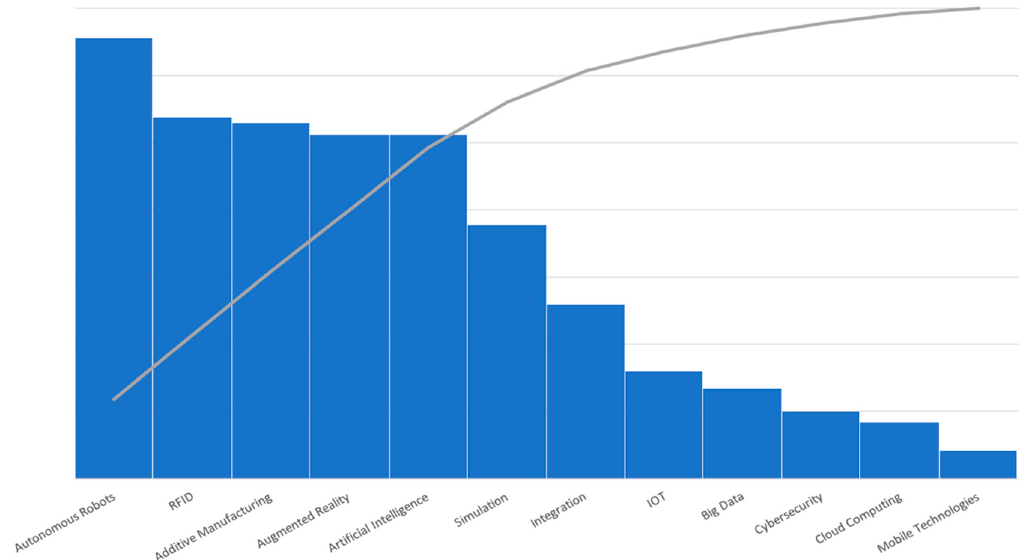
Figure 4. Non ‐ usage of Industry 4.0 technologies (pareto chart). Figure 4. Non-usage of Industry 4.0 technologies (pareto chart).